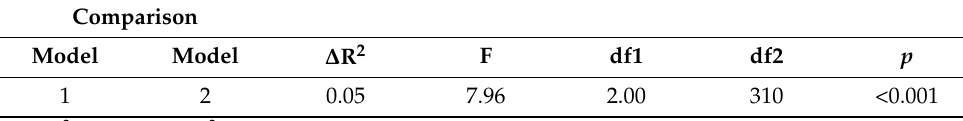
Table 4. Model Comparison for Emotional